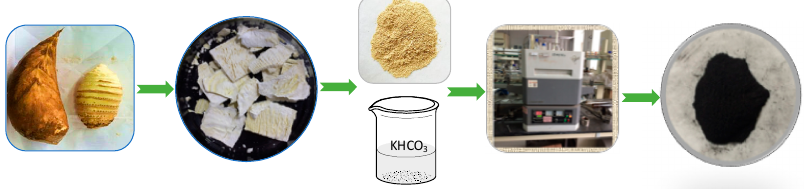
Figure 5. The preparation process of the nitrogen-doped carbon materials.